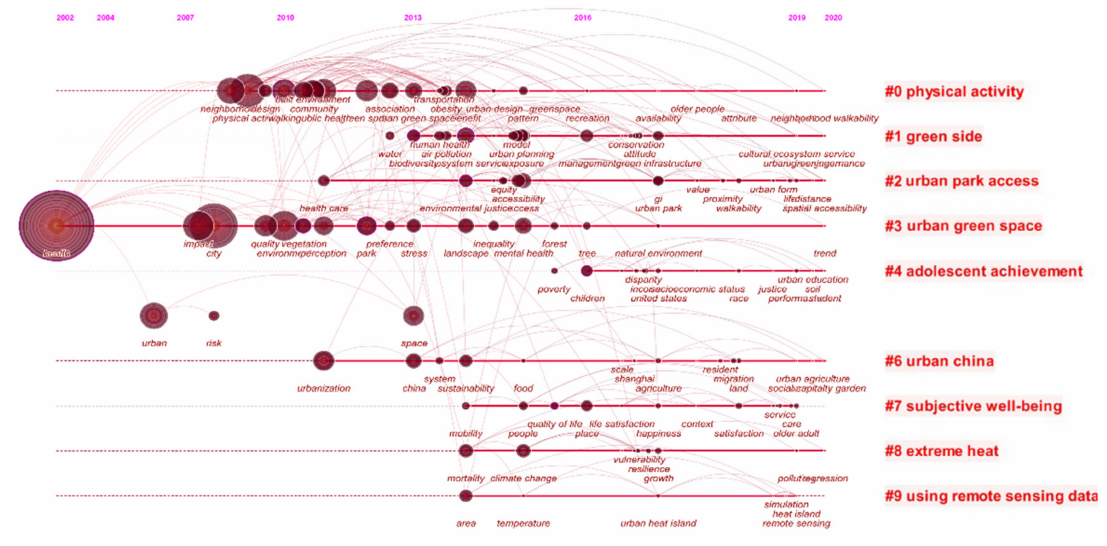
Figure 13. Timeline view of